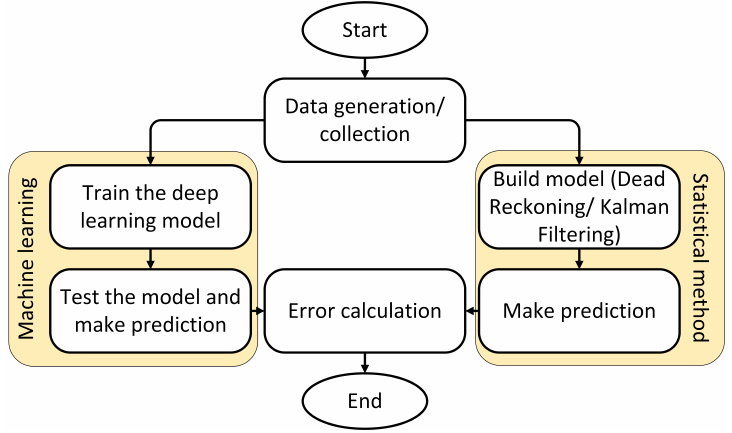
Figure 2. Experimental procedure for the prediction and error